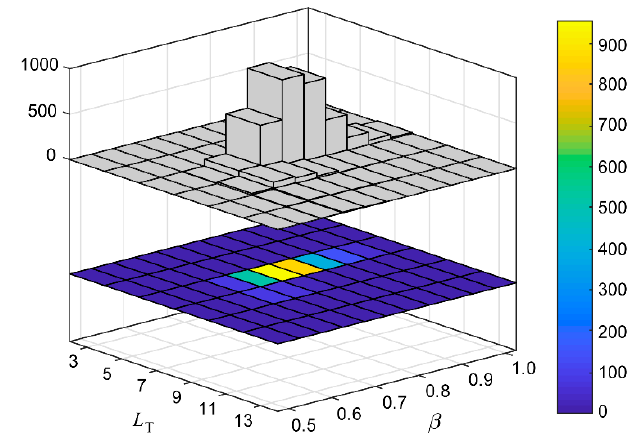
β at 3 kHz to 4 kHz in